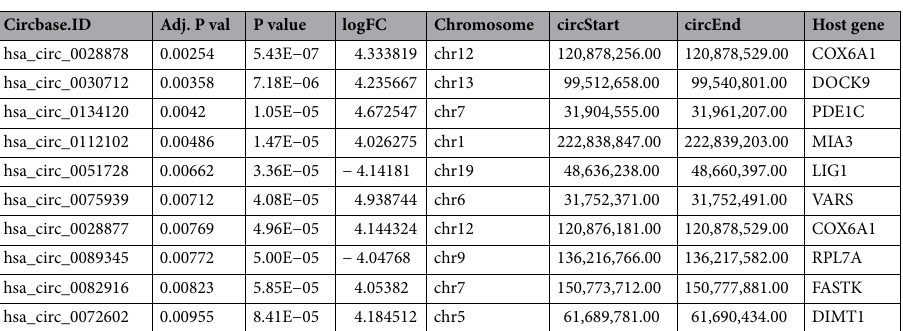
Table 2. Basic information of the 10 target